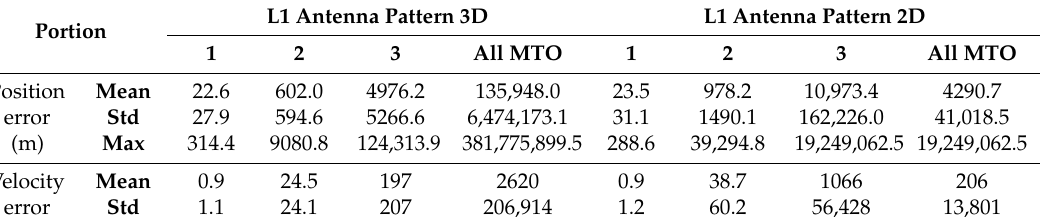
Table 4. Statistics of the single-point least squares estimation error.